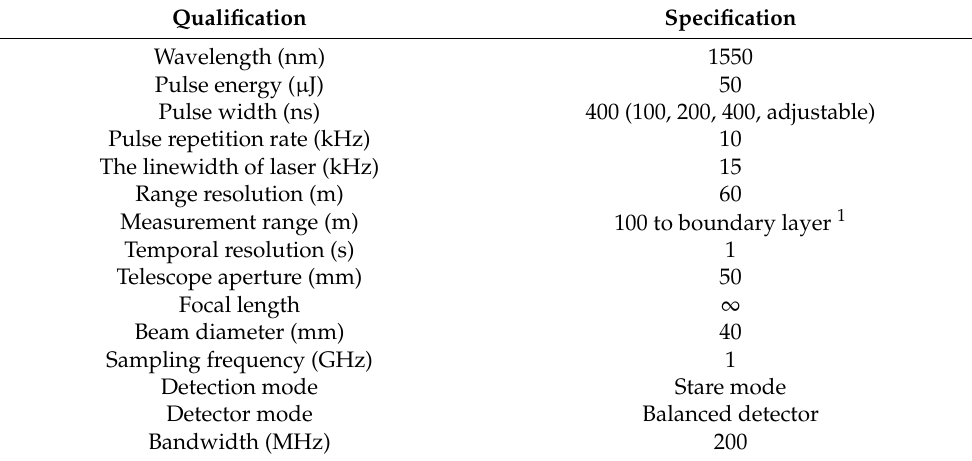
Table 1. The detailed specifications of the all-fiber CDL